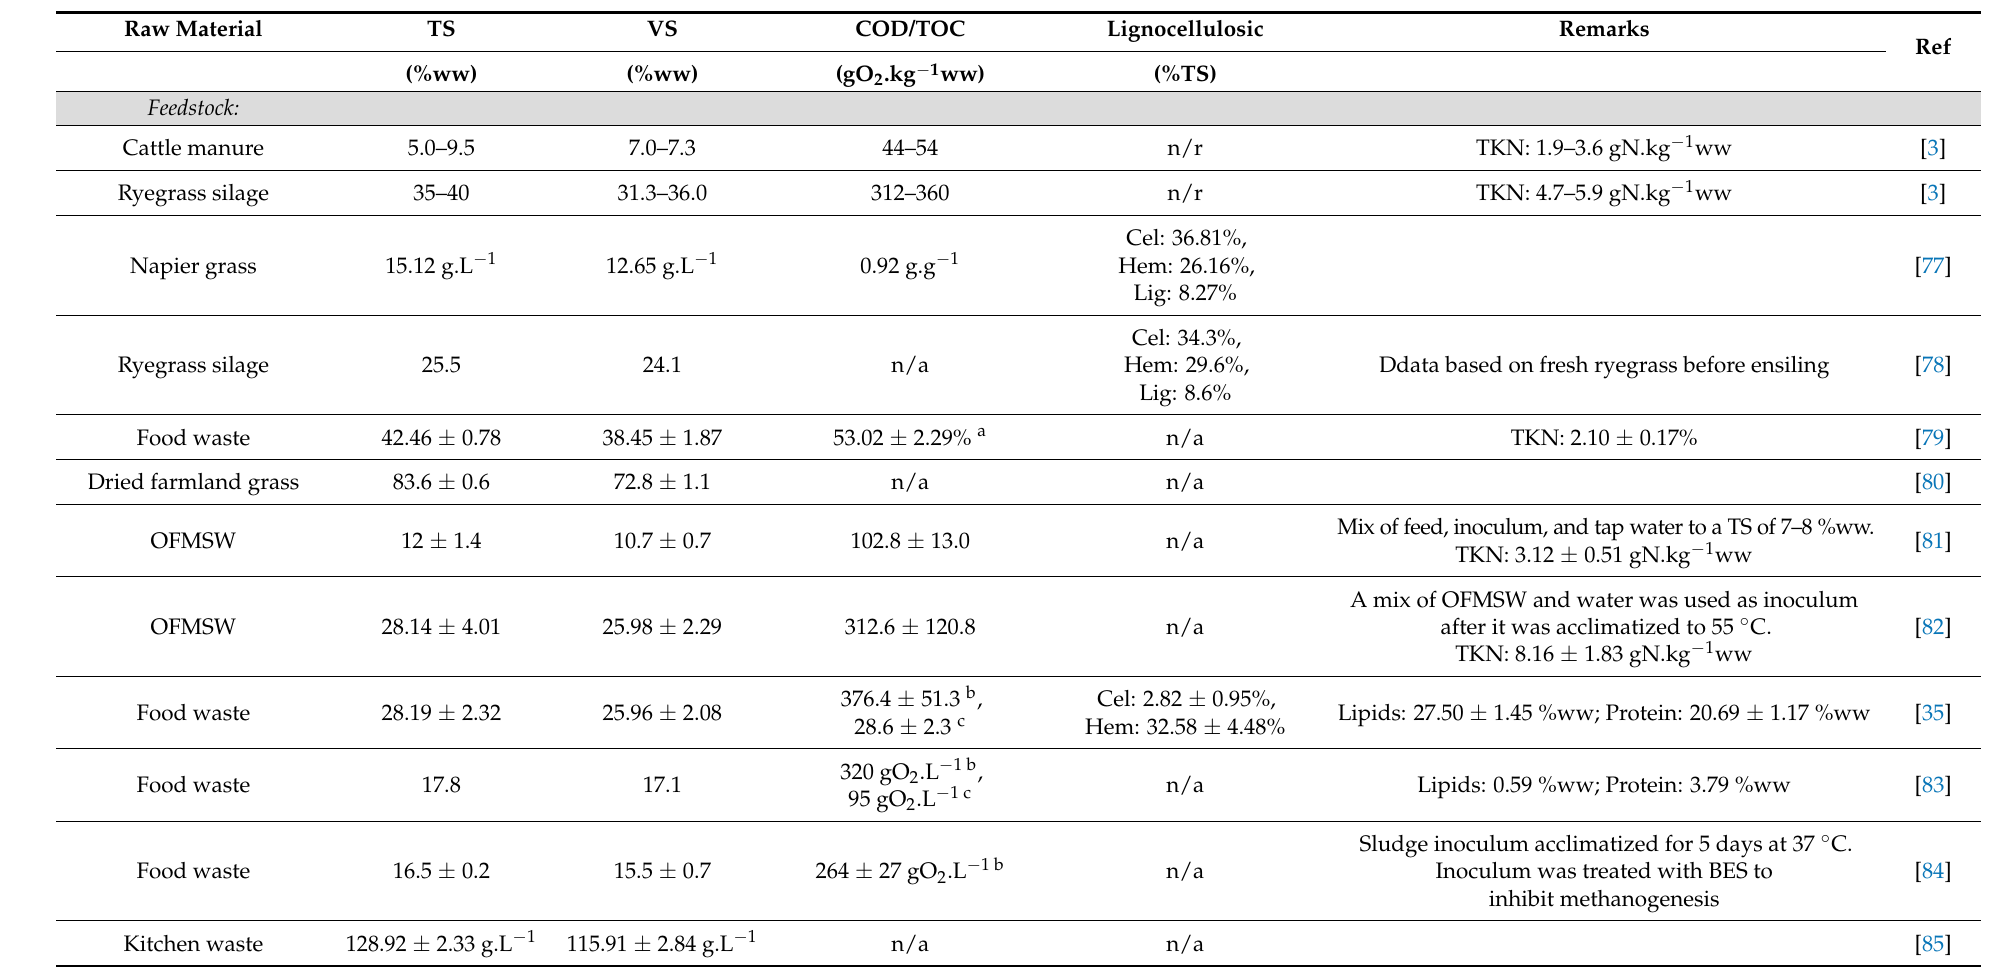
Table 1. Chemical characteristics of feedstocks and inoculum sources used for VFA